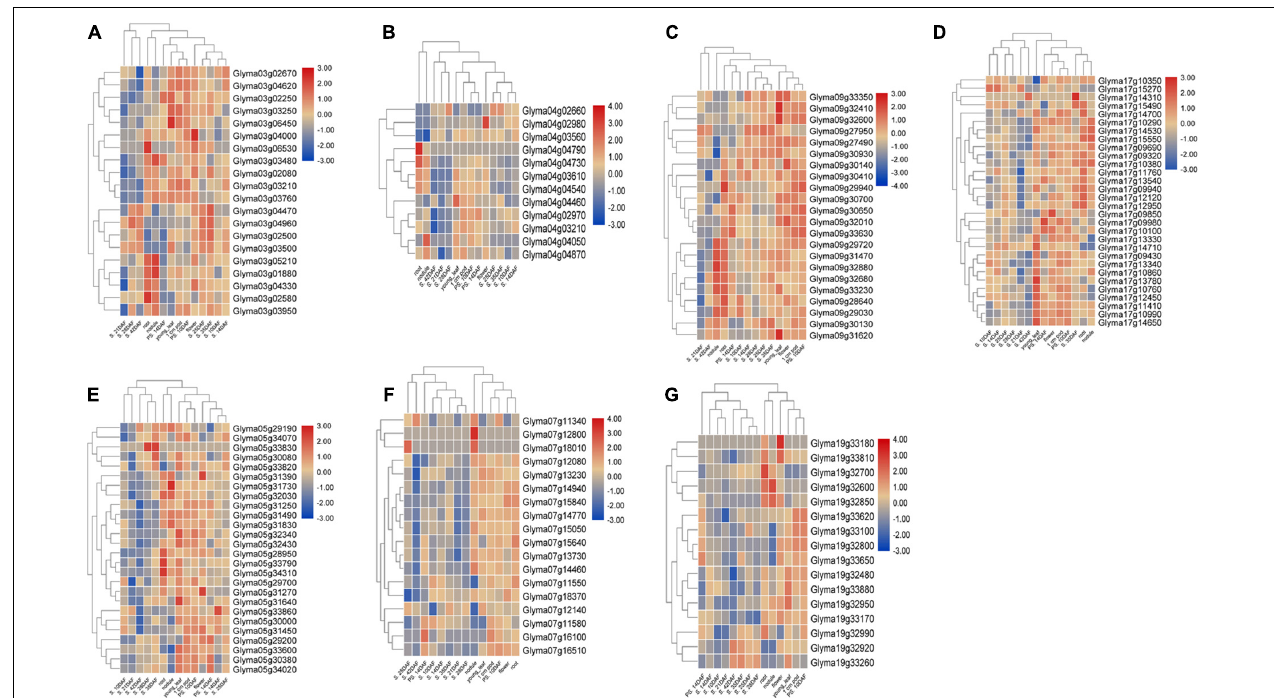
FIGURE 7 | Expression profiling of 47 candidate genes across different development stages in soybean and tissues from seven QTL clusters. (A) Cluster-03 candidate genes, (B) Cluster-4.1 candidate genes, (C) Cluster-5.1 candidate genes, (D) Cluster-07 candidate genes, (E) Cluster-09 candidate genes, (F) Cluster-17.1 candidate genes, and (G) Cluster-19.1 candidate genes. A heat map was generated using the RNA-sequencing data retrieved from publicly available database SoyBase. PS = pod shell, DAF = days after flowering and S =